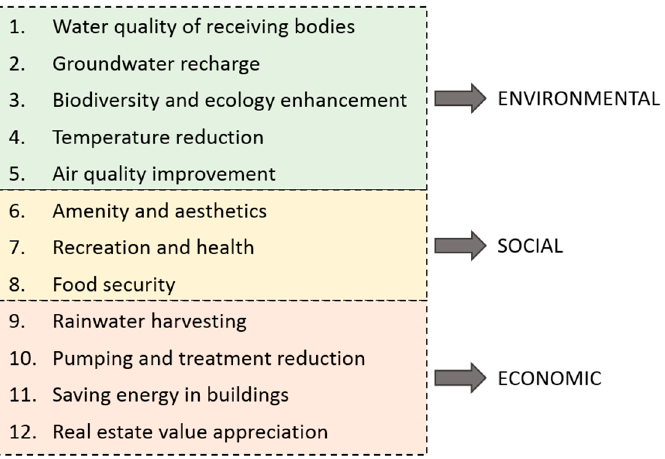
Figure 3. Selected co-benefits classified in the three sustainability dimensions.